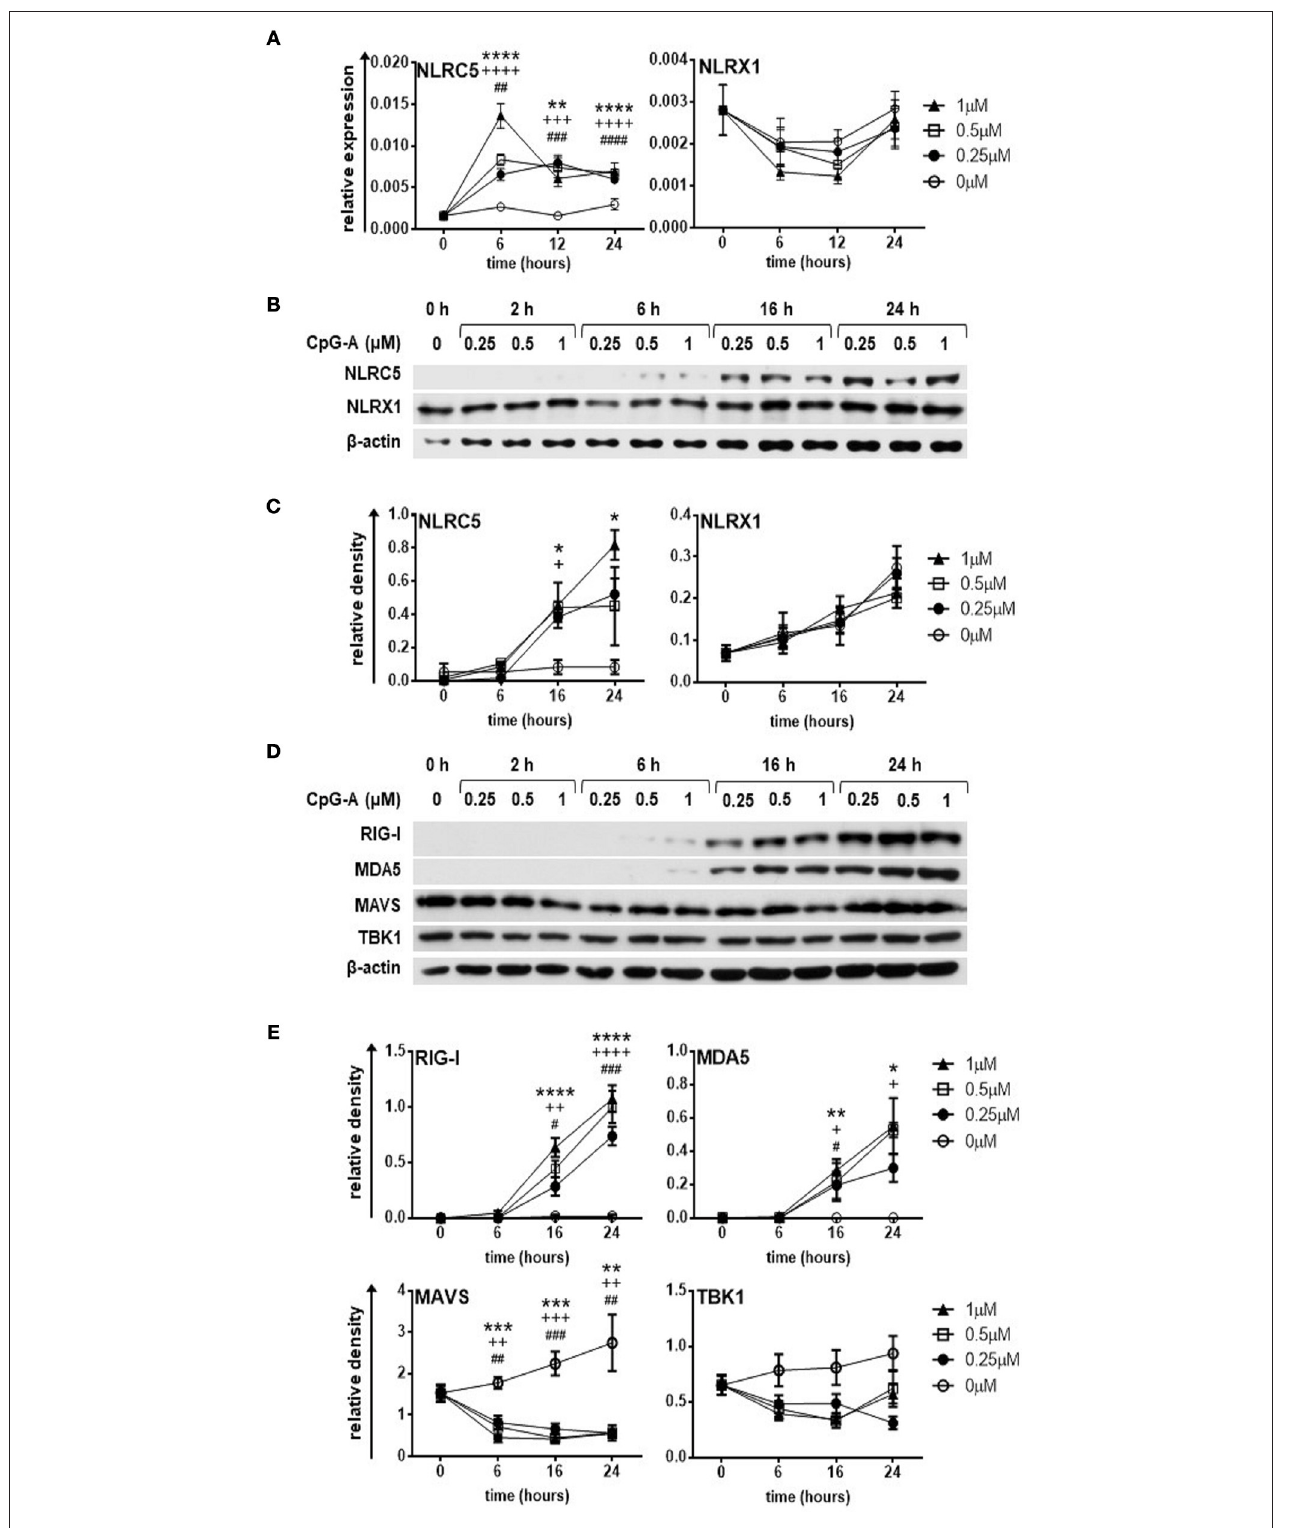
FIGURE 1 | The expression of NLRC5, RIG-I and MDA5 but not that of NLRX1 is upregulated by CpG-A treatment in the human GEN2.2 pDC cell line. (A–E) GEN2.2 cells were treated with increasing concentration of CpG-A (0.25–1 µ M) in a time dependent manner. The expression of NLRC5 and NLRX1 was measured at the